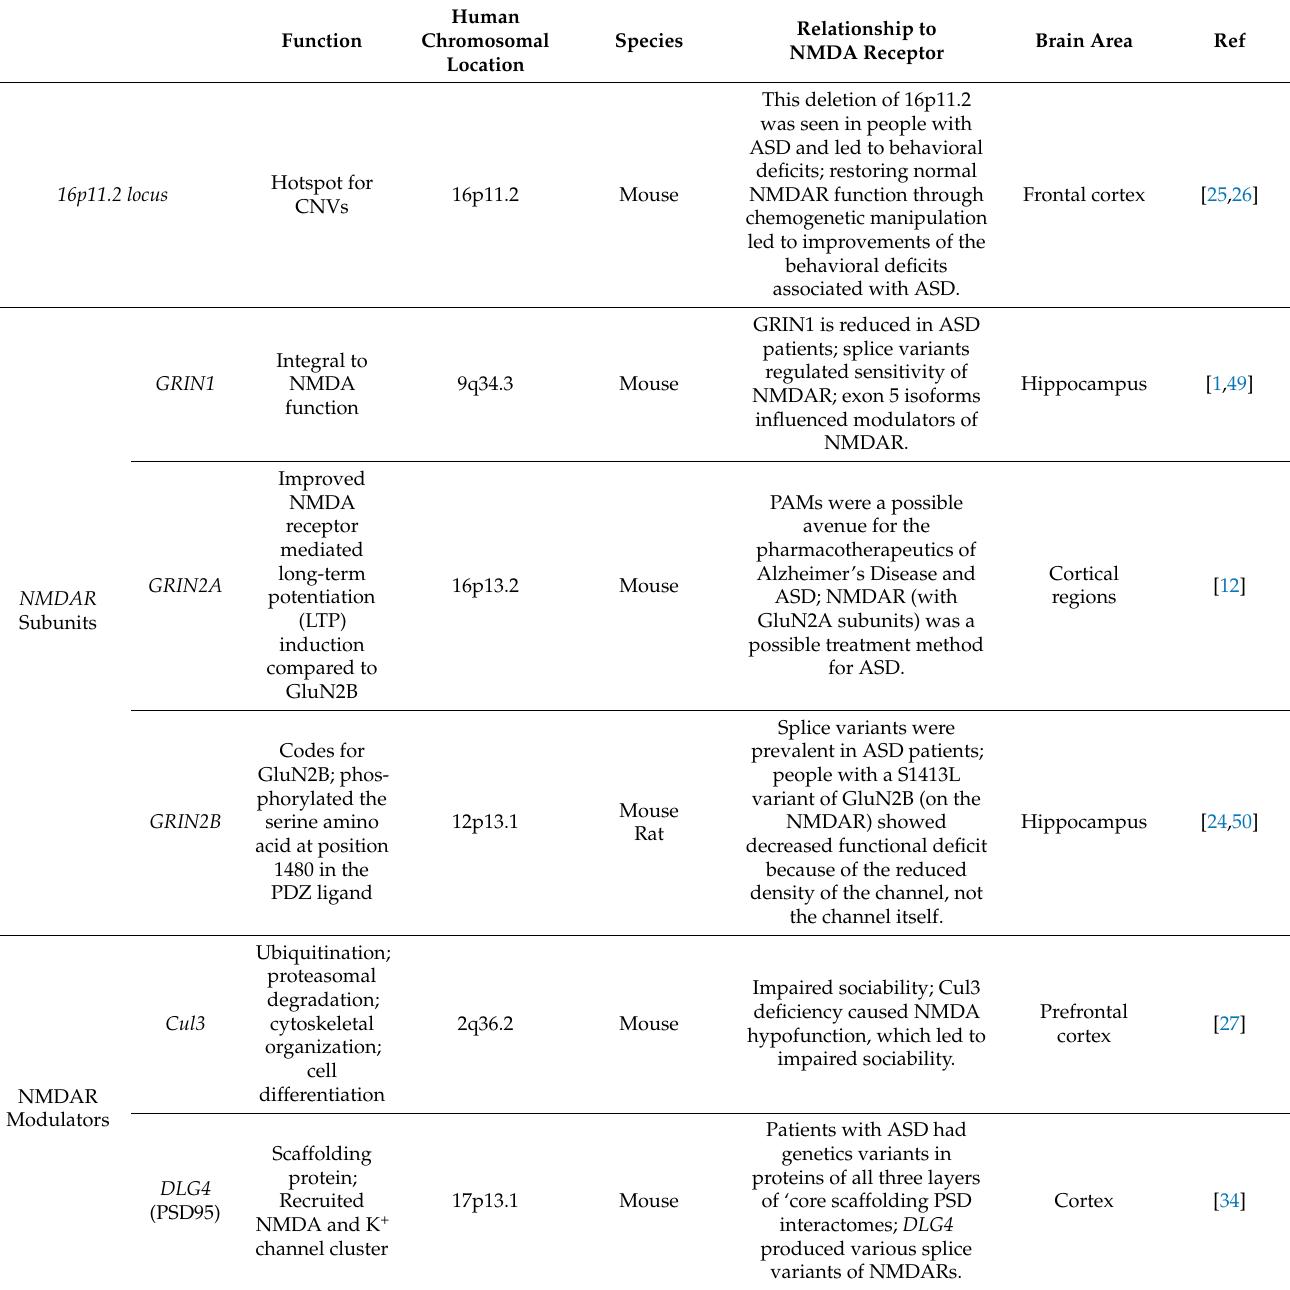
Table 1. Summary of the subunits, modulators, and positive allosteric modulators (PAMs) of N- methyl- D-aspartate receptors